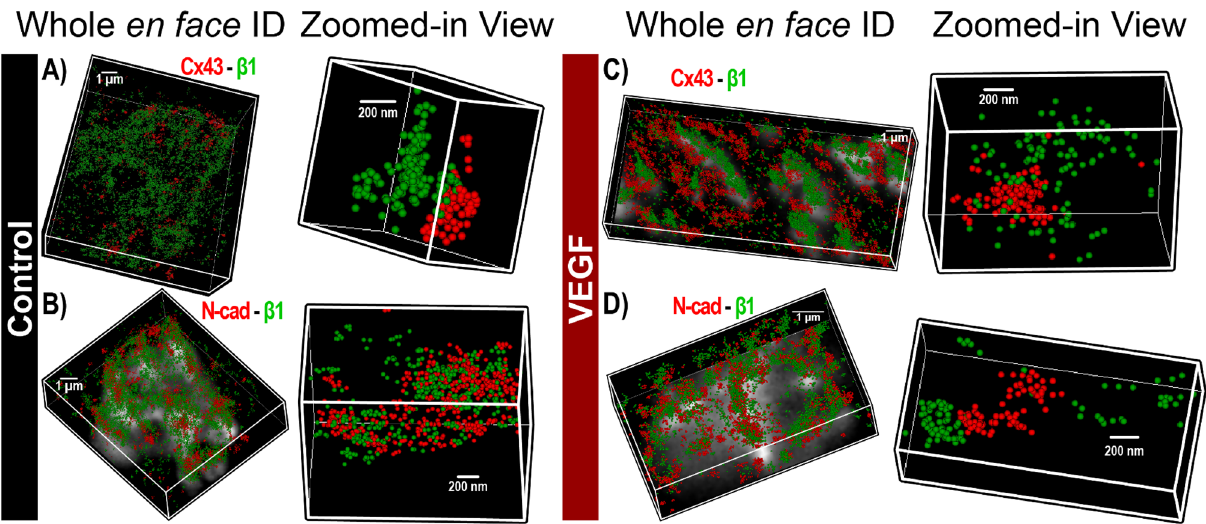
Figure 8. STORM imaging of atrial IDs—β1. Representative 3D STORM images of en face IDs immunolabeled for β1 along with Cx43 and N-cad from ( A , B ) control and ( C , D ) VEGF-treated murine